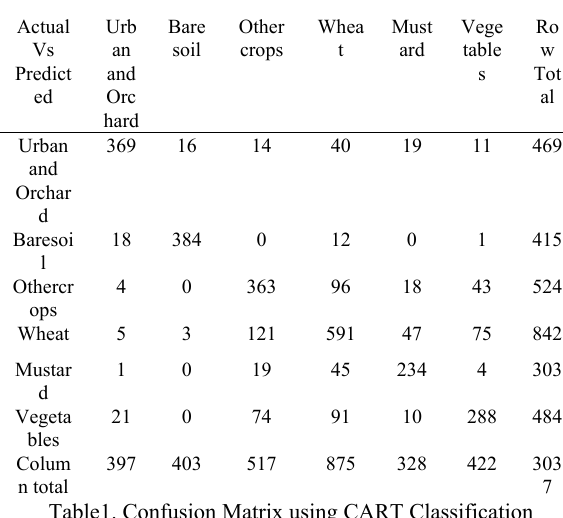
Table1. Confusion Matrix using CART Classification